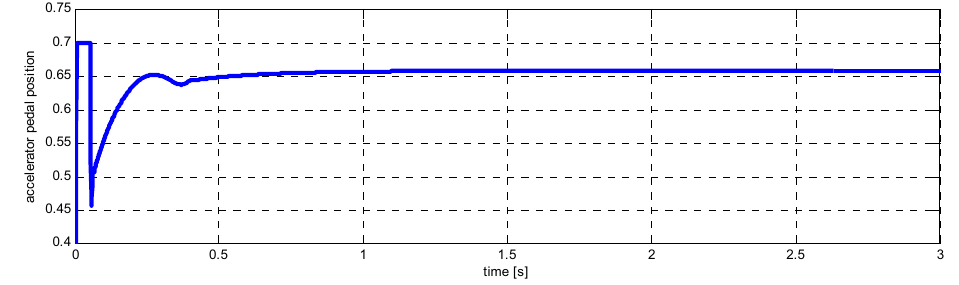
Figure 9. Accelerator pedal position under pedal self-correcting traction allocation.